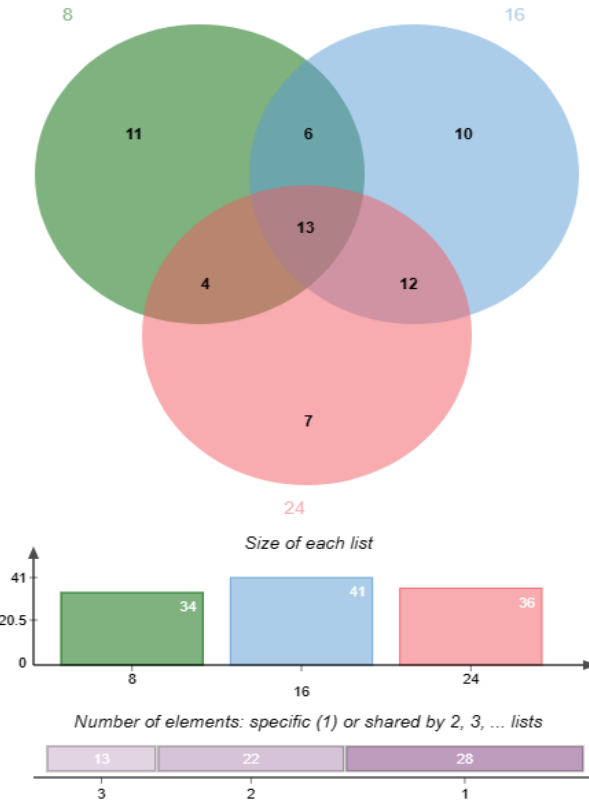
Figure 3. Venn diagrams showing the variable importance in projection analysis (VIP) markers (FC ≥ 2; VIP score > 1) in extracts from T. baccata cell suspensions either untreated (control) or elicited with 1 μM coronatine (COR) or 150 μM salicylic acid (SA): at each experimental time point (days 8, 16, and 24) in both elicited cultures. The complete lists of VIP markers are provided in Tables S2–S4.